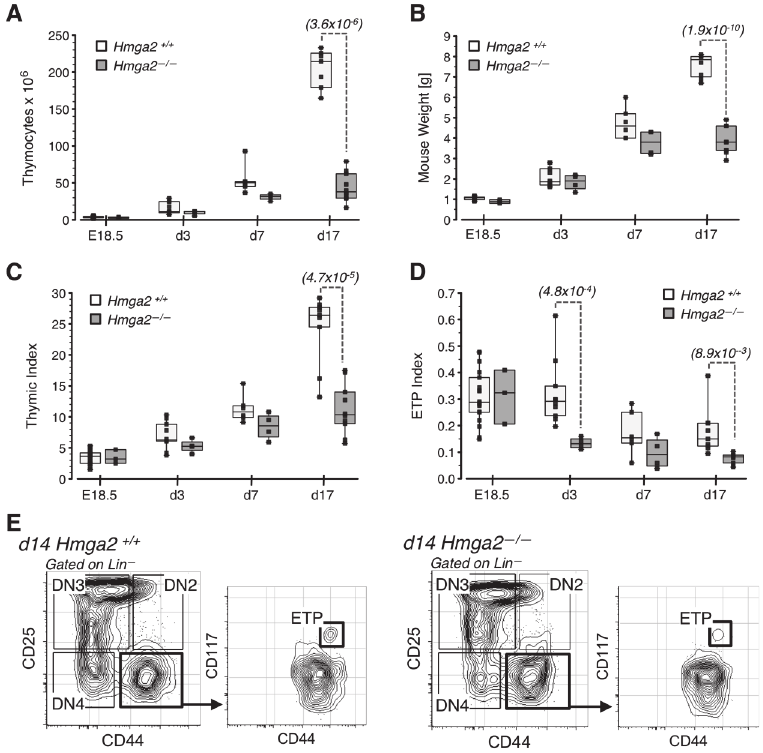
Fig 2. Thymopoiesis in Hmga2 -/- mice. (A) Total thymocyte numbers, (B) Mouse weight in grams, and (C) Thymic Index (thymocyte number/mouse weight in grams) for Hmga2 -/- and Hmga2 +/+ mice of the indicated ages. (D) ETP Index, defined as ETP number/mouse weight in grams for each mouse. The boxes and lines in panels A-D indicate the 95% confidence interval and median for each group, respectively. Each symbol represents a mouse. The number of animals per group were as follows: Hmga2 -/- (E18.5, n = 3; d3, n = 4; d7, n = 2, and d17, n = 5) and Hmga2 +/+ (E18.5, n = 18; d3; n = 10; d7 , n = 2 , and d17 , n = 6) . The indices were used in order to account for differences in size and weight between Hmga2 -/- and Hmga2 +/+ mice. (E) Representative FACS plots of ETP from day 14 Hmga2 -/- and Hmga2 +/+